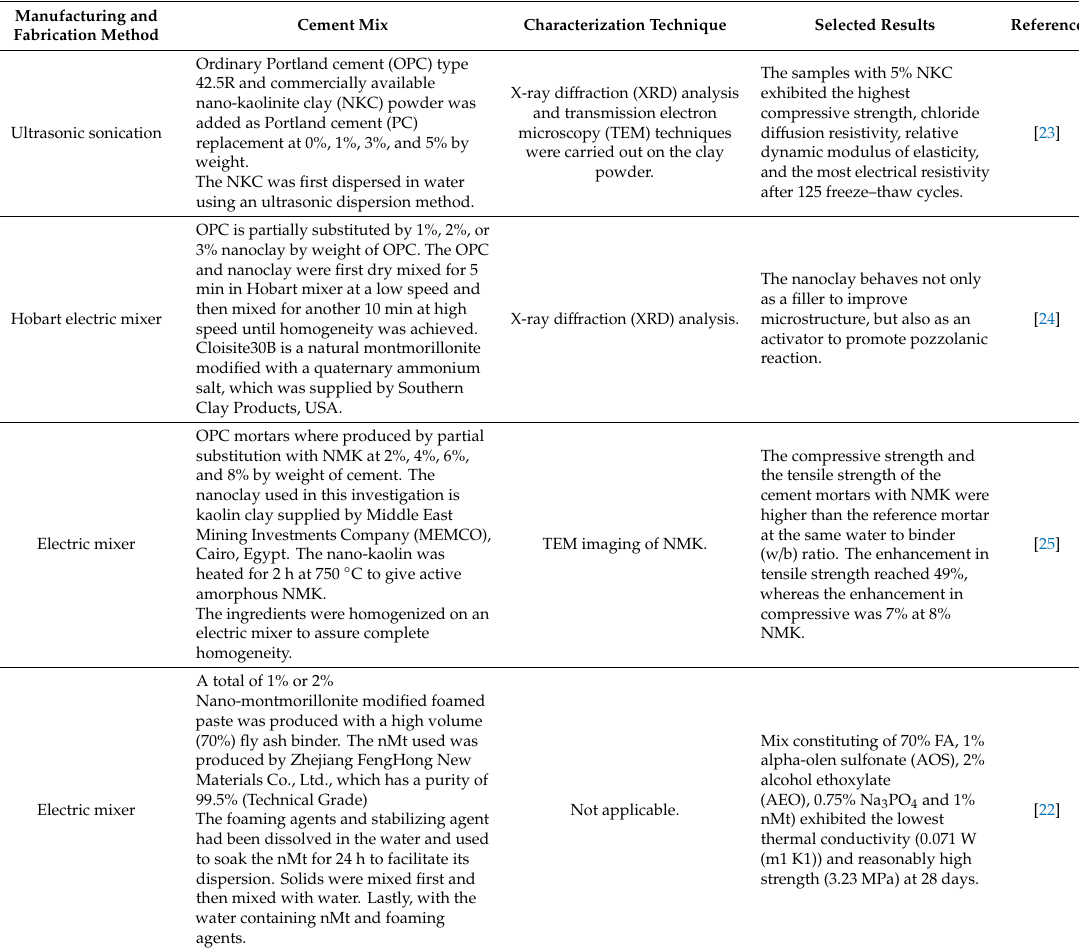
Table 1. Manufacturing and fabrication method of nano-montmorillonites / nanoclays suitable for cement nanocomposites according to